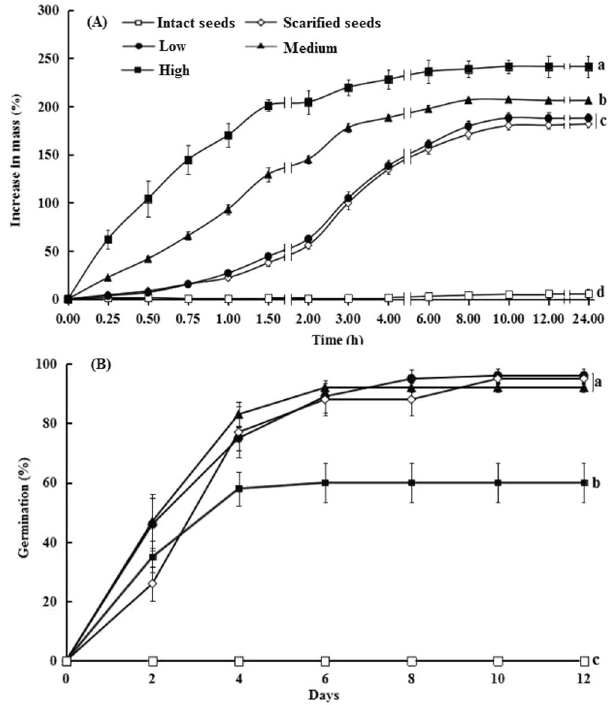
Figure 1. Time-course for increase in mass via water absorption at ambient laboratory conditions ( A ) and for germination ( B ) (mean % ± se) of intact nonscarified, scarified and of the three classes of seed predation of Astragalus lehmannianus in light at 30/15 °C. Different lowercase letters indicate significant differences for final increase in mass ( A ) and final germination percentage ( B ) ( P <